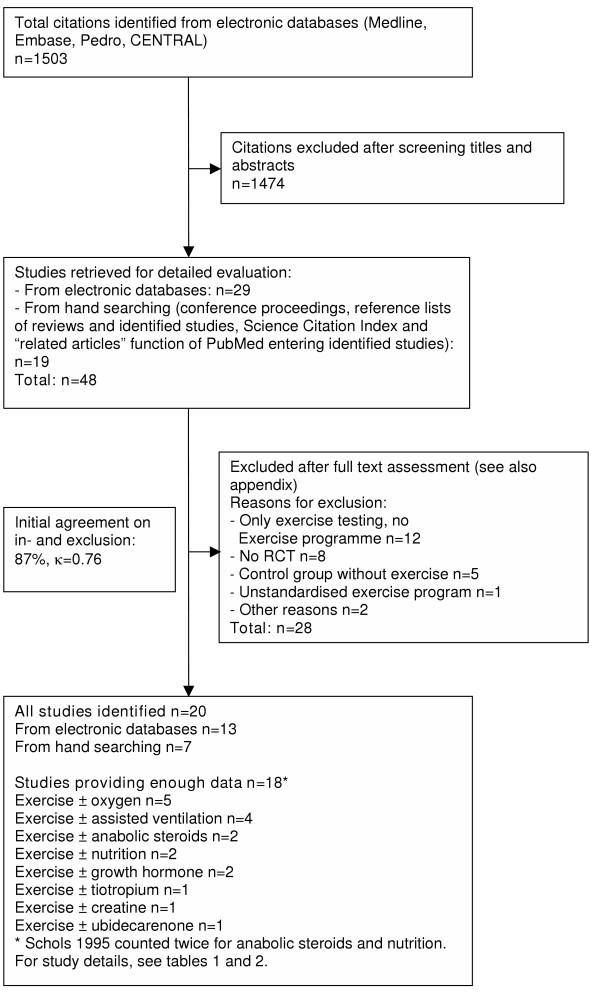
Study flow from identification to final inclusion of studies.